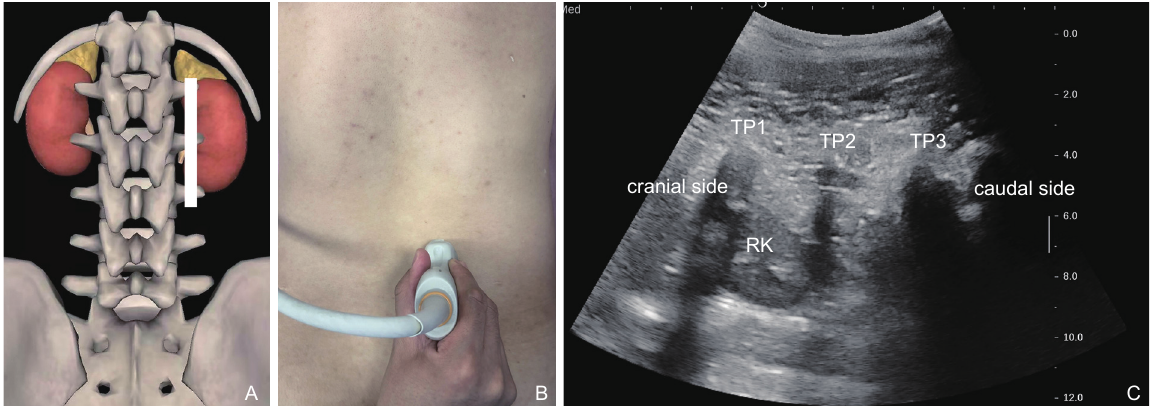
Figure 2 Longitudinal section of the transverse processes from L1 to L3. (A) The white line indicates the location of the probe on the reconstructed CT image. (B) The position of the probe on human skin. (C) Ultrasound image of the L1-L3 transverse processes under the probe. TP1, the transverse process of L1; TP2, the transverse process of L2; TP3, the transverse process of L3; RK, right kidney.